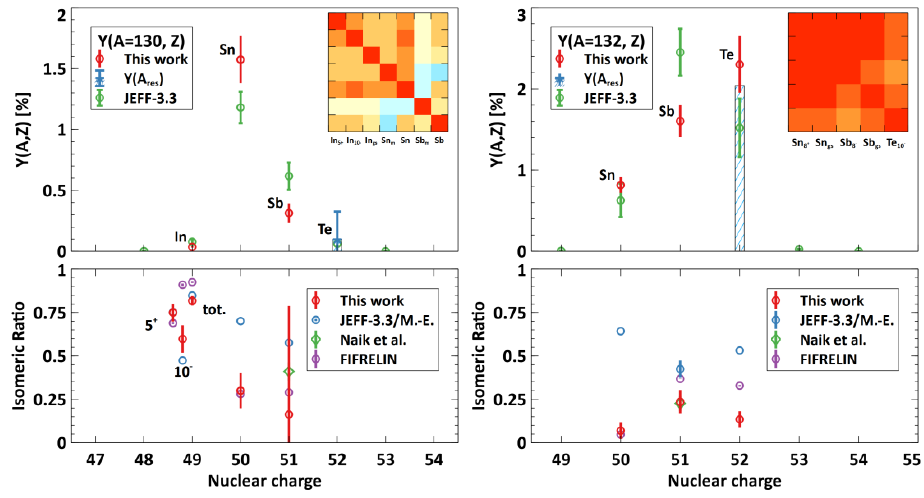
Fig. 2. Results for the masses 130 (left) and 132 (right). (Top plots) Isotopic yields with their correlations have been compared with the library JEFF-3.3. The hatched bars correspond to the residual isotopic yields which are not measured with gamma spectrometry but deduced from the mass yields measurements. (Bottom plots) Isomeric ratios for different isotopes compared to the FIFRELIN calculations, the JEFF-3.3 evaluations and the H. Naik et al. interpretations